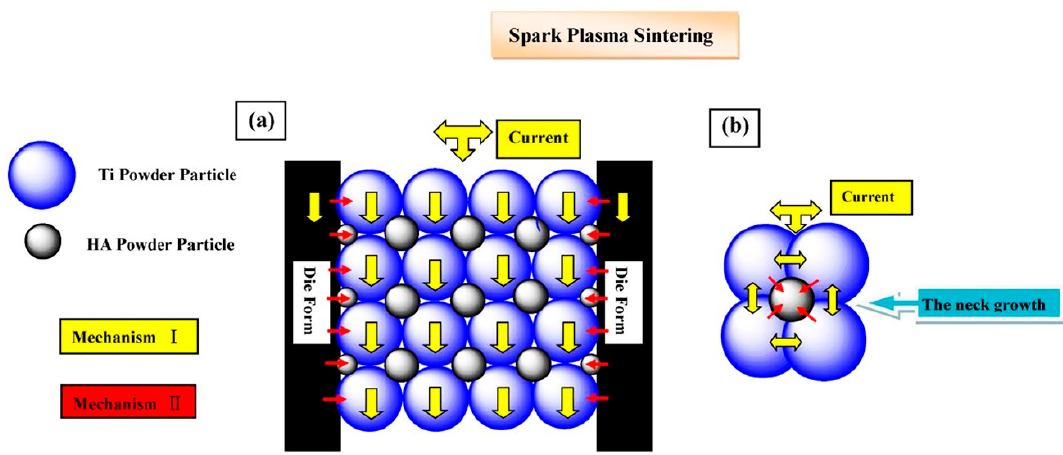
Figure 11. Schematic illustration of the local current distribution and the neck growth between particles of Ti-HA biocomposites. The yellow arrows indicate the effect of mechanism I (Spark plasma discharge mechanism), and the red arrows indicate the effect of mechanism II (Heat-transfer mechanism). ( a ) Since the electrical conductivity of HA was much lower than Ti, the current preferentially flowed to Ti particles and the die body; ( b ) High temperature plasma (spark plasma) generated in the gaps between Ti powder particles through Mechanism I, contributing to vaporization and themelting of the particle- contacting zones. Then, lots of joule heating of HA particles got from the surrounding Ti particles and die form through Mechanism II [30].